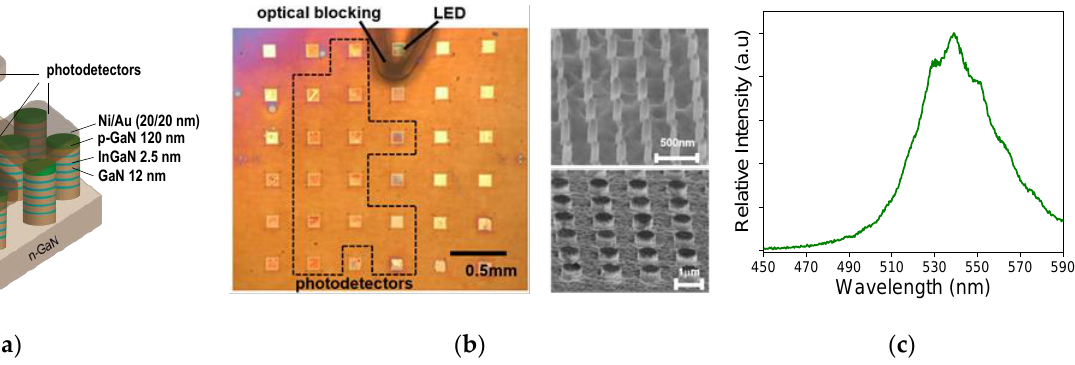
Figure 1. ( a ) Schematic of the proposed spectrometer chip with a monolithically integrated LED. As shown in the illustration, there are three photodetectors and one LED separated by an optical blocking structure. The three photodetectors exhibit different spectral responses due to the difference of the nanopillar diameter. ( b ) The optical image of the as-fabricated spectrometer chip with a monolithically integrated LED light source. Each yellow square is a nanopillar array with a chip area of 100 µm × 100 µm. The nanopillar diameters of the 13 arrays enclosed by the dashed line vary from 55 nm through thin film (see Figure 3a,b for the diameter values). The black-colored structure is the enamel-coated PET optical blocking structure to suppress the direct capture of the LED emission by the photodetectors. The edge-to-edge spacing between two arrays is 0.3 mm. The two scanning electron micrographs show two nanopillar arrays after etching but before planarization. The diameters of the nanopillars are 80 nm and 800 nm for the images on the top and bottom, respectively. ( c ) The emission spectrum of the on-chip LED (biased at 8V) measured by Ocean Optics HR2000. The LED device is also a nanopillar array with a diameter of 200 nm.